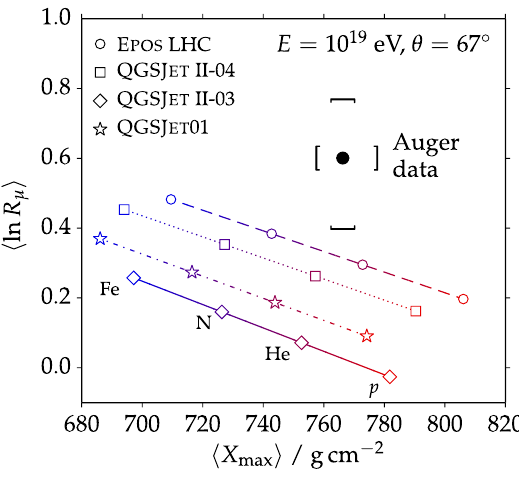
Figure 5. Average logarithmic muon content (cid:104) lnR µ (cid:105) as a func- tion of the average shower depth (cid:104) X max (cid:105) Model predictions are obtained from showers simulated at θ = 67 ◦ and E = 10 19 eV.